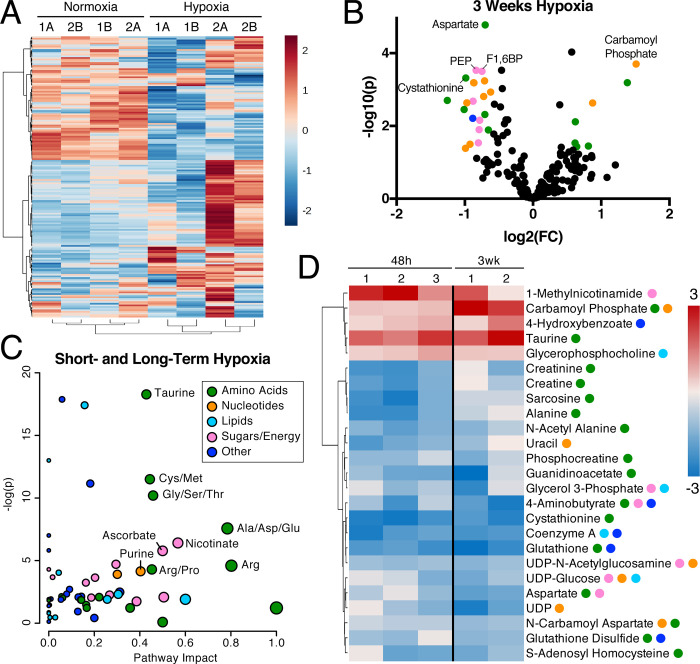
Long-term hypoxia alters the metabolite profile of microvascular cells.(A) Fold change metabolite abundance over normoxia control for 175 metabolites detected in all samples as measured by LC-MS/MS in HMEC-1 cells grown in hypoxia for 3 weeks. Number indicates biological replicate, letter represents technical replicate. (B) Effect size and significance by t-test of metabolite changes measured in A. Colored circles indicate p < 0.05 and fold change > 1.5. Top five most significant metabolites over 1.5-fold change are labeled. Colors indicate pathways: green, amino acid metabolism; orange, nucleotide metabolism; pink, sugar and energy metabolism; blue, other. (C) Metaboanalyst 4.0 Pathway Analysis comparing effects of hypoxia at 48 hrs and 3 weeks to normoxia. Metabolites measured at only one time point were excluded for a total of 150 metabolites detected in all samples. (D) Top 25 most significantly altered metabolites in hypoxia at 48 hrs and 3 weeks compared to normoxia controls. Abbreviations: Ala, alanine; Arg, arginine; Asp, aspartate; Cys, cysteine; F1,6BP, fructose-1,6-bisphosphate; Glu, glutamate; Gly, glycine; Met, methionine; PEP, phophoenolpyruvate; Pro, proline; Ser, serine; Thr, threonine; UDP, uridine diphosphate.